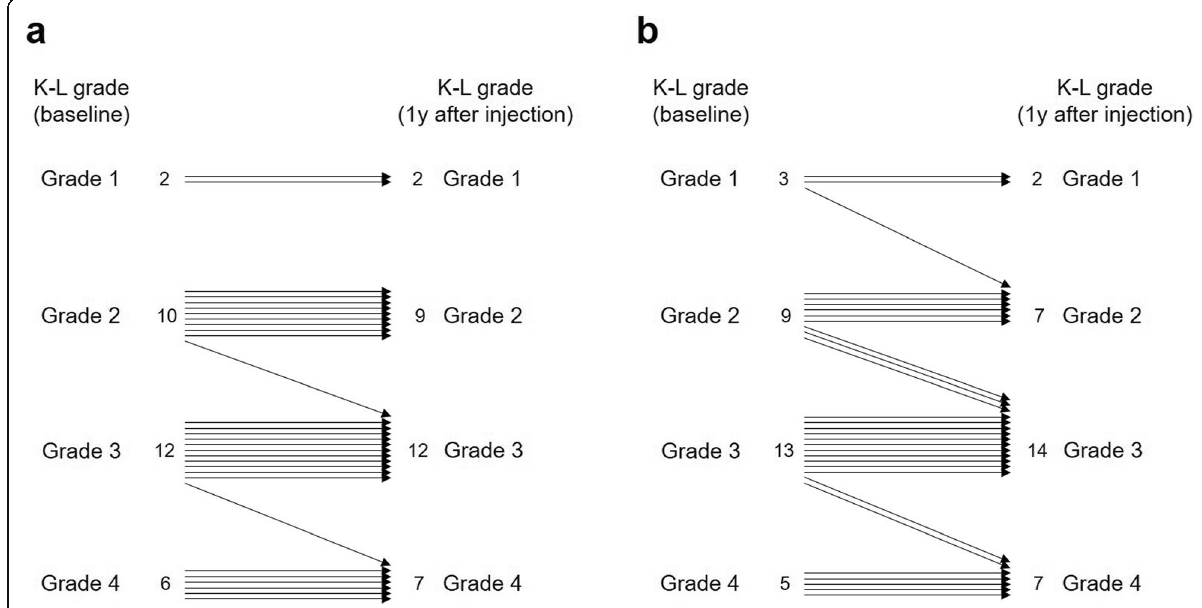
Fig. 3 Changes in Kellgren-Lawrence (K-L) grades from baseline to 1-year post-injection in MSC a and HA b